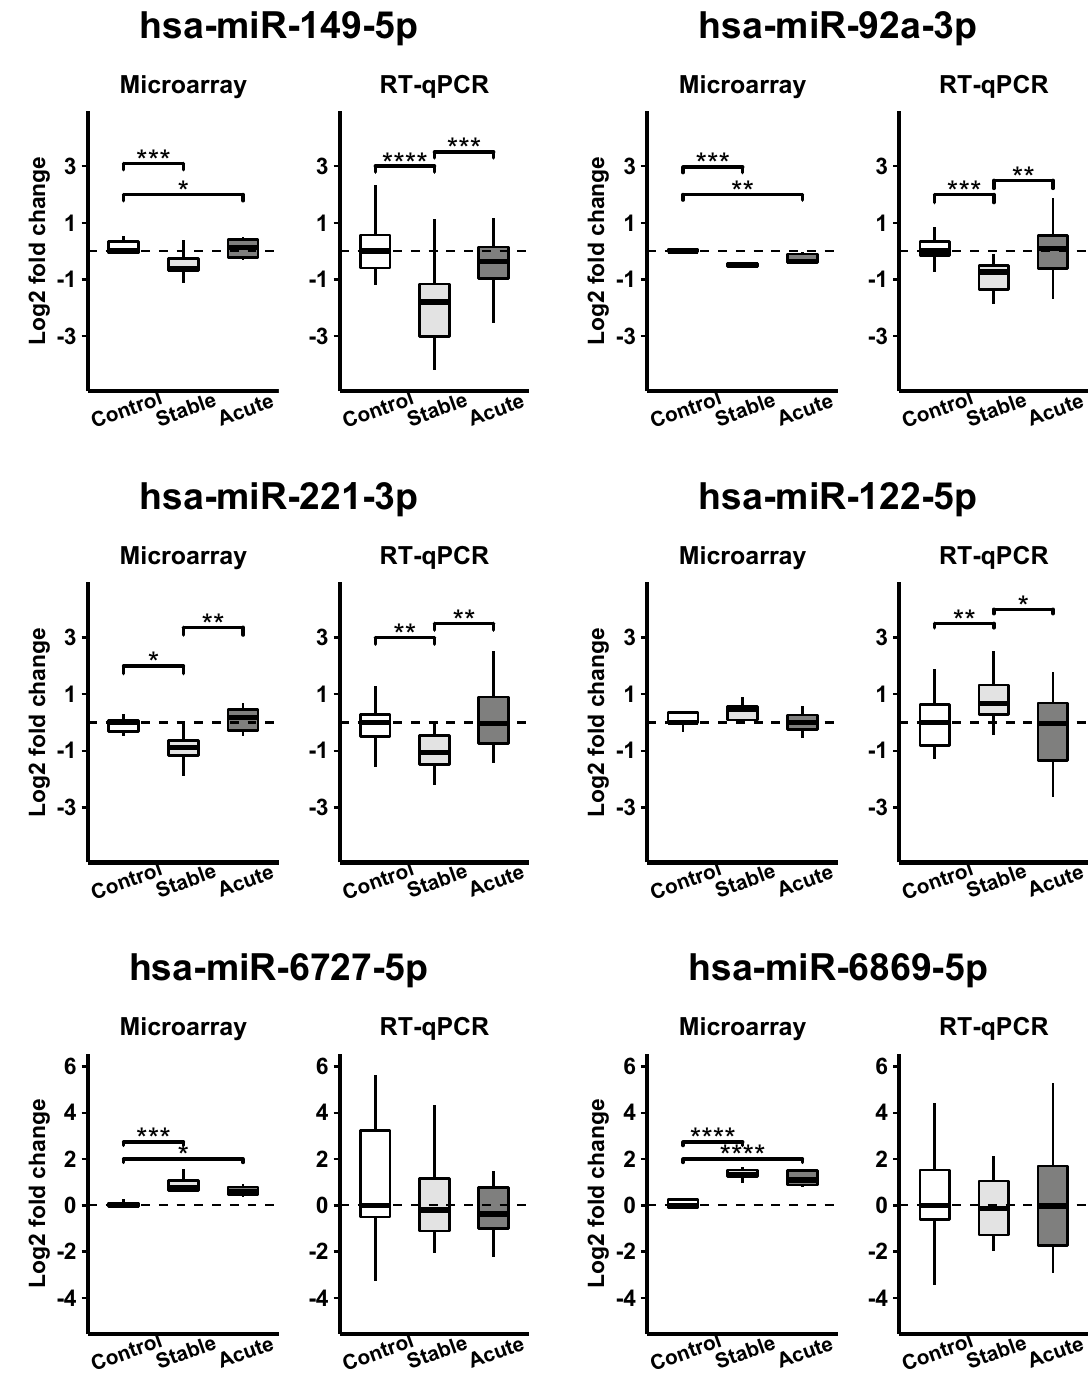
Figure 4. Validation of differentially expressed miRNAs in the studied patient groups by RT-qPCR. Brackets represent p value of pairwise Mann–Whitney test in RT-qPCR figures and p value of pairwise limma comparison in microarray data. * p < 0.05, ** p < 0.01, *** p < 0.001, **** p <